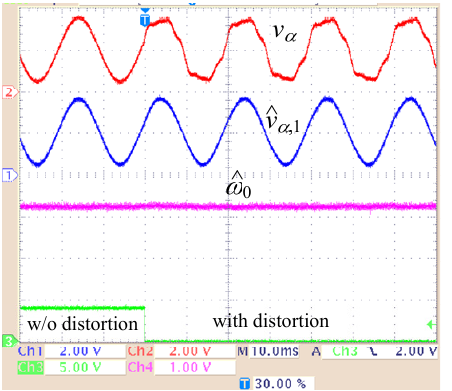
Figure 7. Transient response of the proposed SOHO-based FLL at f 0 = 50 Hz after going from a pure sinusoidal to a distorted reference of: (from top to bottom) v α ( y -axis: 200 V/div), ˆ v α ,1 ( y -axis: 200 V/div), ˆ ω 0 ( y -axis: 97.66 rd/s/div) and enabling signal ( x -axis: 10 ms/div in all